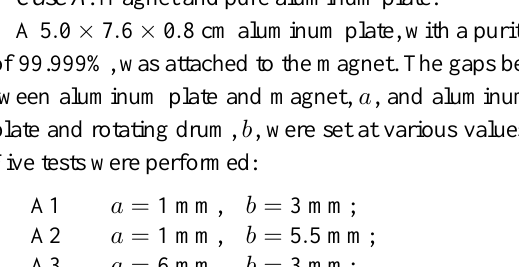
Case A : Magnet and pure aluminum